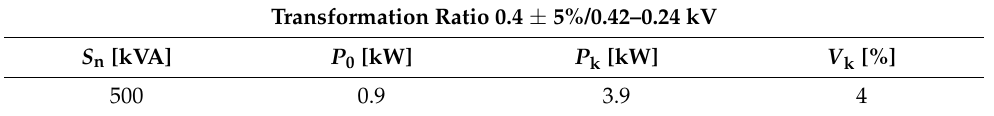
Table 9. Electrical data of the LV/LV transformers.